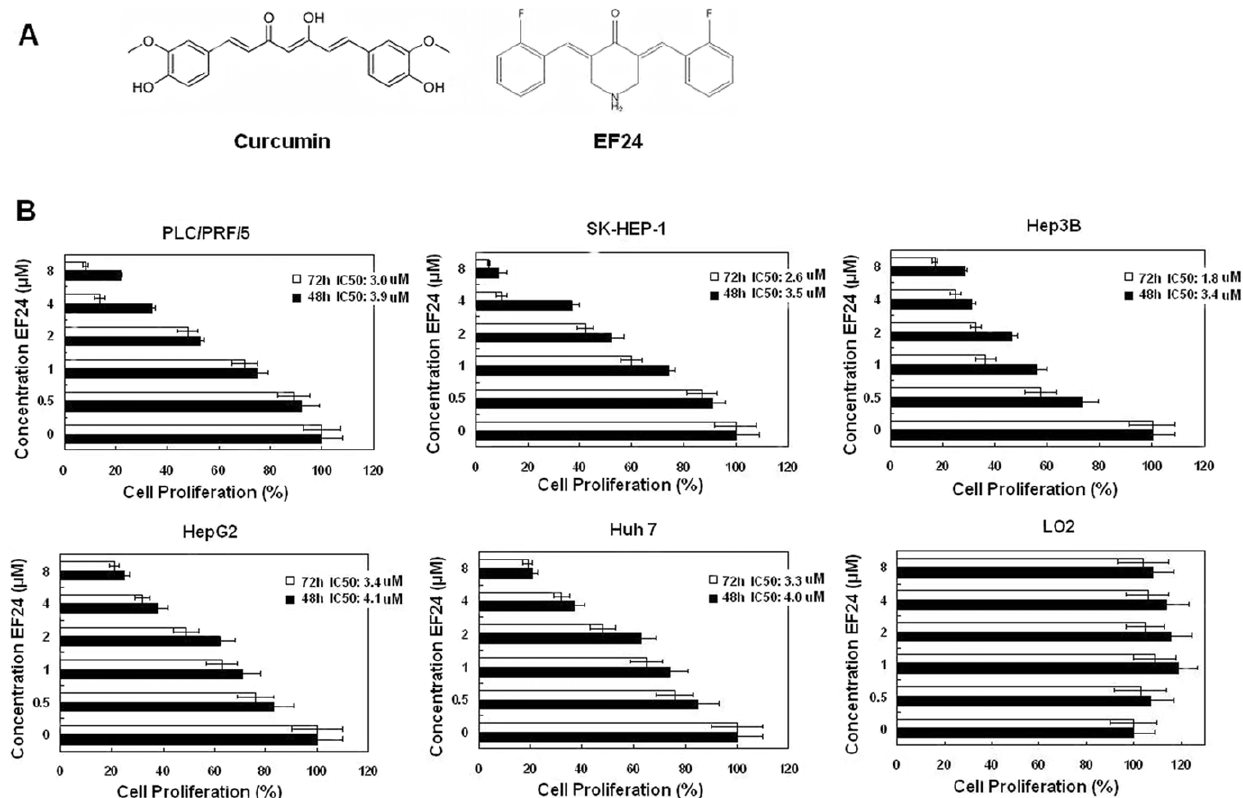
Figure 1. EF24 inhibited liver cancer cell proliferation. ( A ). The topological structures of curcumin (diferuloylmethane) and EF24 (diphenyl difluoroketone). ( B ). EF24 treatment on proliferation of PLC/PRF/5, SK-HEP-1, Hep3B, HepG2, Huh 7 and LO2 cells. These cells were incubated with increasing doses of EF24 (0.5–8 m mol/L) for 48-h and 72-h periods and analyzed for cell proliferation using cell counting kit-8 assay.